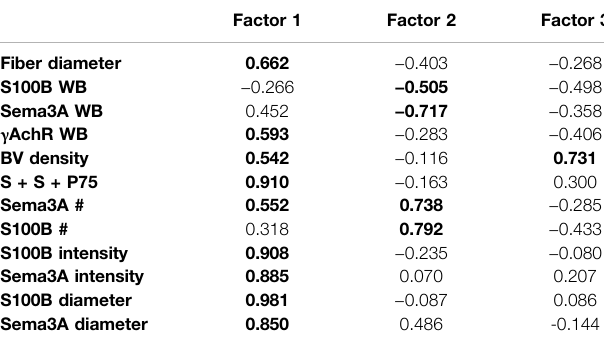
TABLE 3 | Loading correlations of variables onto 3 factors identi fi ed by principal component analysis of the dataset of untreated muscles regenerating from injury. WB indicates data originated from Western blotting assays, BV = blood vessel; # indicates the number ofexpression sites (by in situ hybridization, ISH); “ S + S + P75 ” indicates the number of regions in which P75 protein (by immunostaining) was colocalized with S100B and Sema3A transcripts (by ISH). Loading coef fi cients greater than 0.5 (in bold type) were considered strong